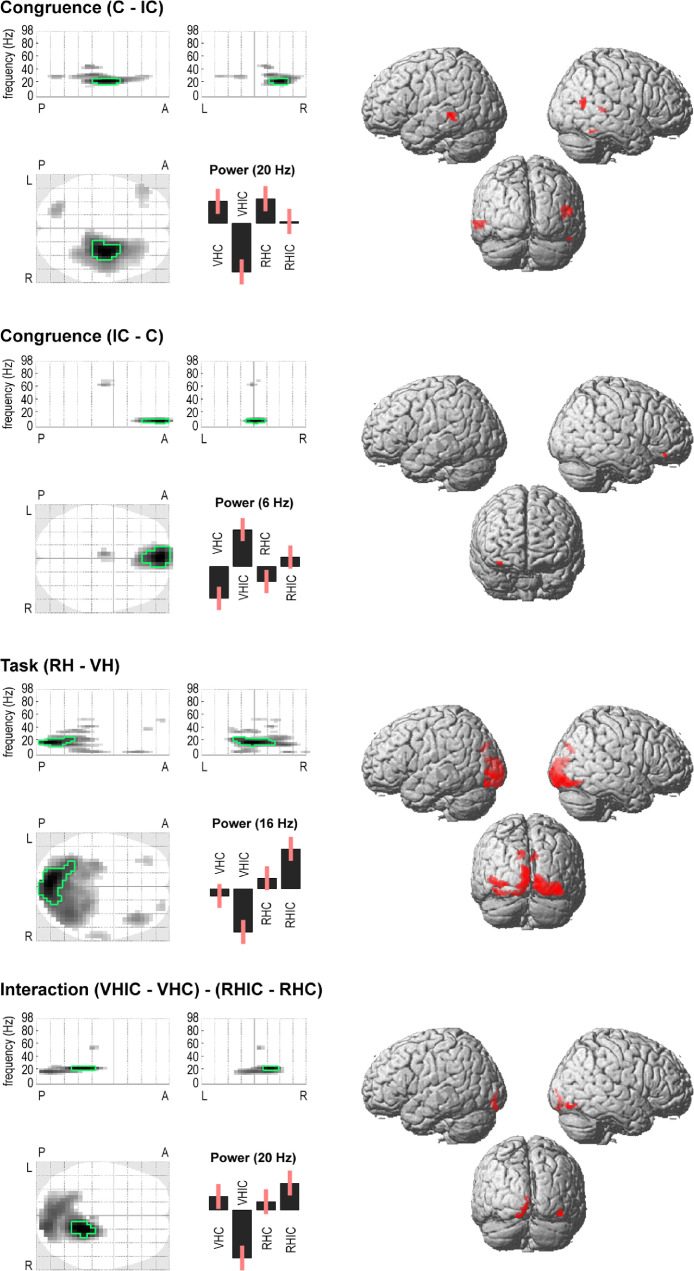
MEG spectral differences and corresponding source reconstructions. The ‘glass brain’ (maximum intensity) projections show the sensor level scalp-frequency maps of induced power differences between conditions depending on sensory (Congruence) and cognitive-attentional (Task) factors, and their interaction (in each plot, the darkest voxel shows the strongest effect along the respective projection; the maps are thresholded at p < 0.001, effects significant at pFWE < 0.05 are outlined in green; the top plots have one frequency dimension, 0–98 Hz, and one spatial dimension, P-A = posterior-anterior, L-R = left-right; the bottom plot has two spatial dimensions). The bar plots show the mean-centered estimates of oscillatory power in each condition from the respective peak voxel (strongest effect in scalp-frequency space), in arbitrary units and with associated standard errors. VH = virtual hand task, RH = real hand task, C = congruent hand mapping, IC = incongruent hand mapping. The renders show the corresponding source localization results using variational Laplace with multiple sparse priors (all suprathreshold voxels are colored in red, the intensity indicates the respective T statistic value, weighted by a function of its distance behind the brain surface). See Results for details. (For interpretation of the references to colour in this figure legend, the reader is referred to the web version of this article.)